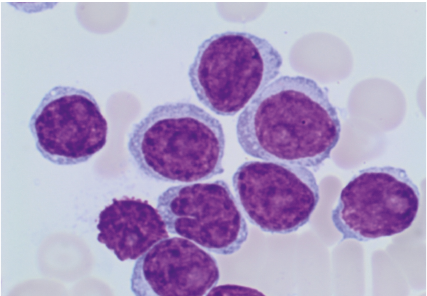
Figure 1: Peripheral blood smear. The lymphoid cells are of intermediate to large size with a prominent nucleolus and cytoplasm protrusions (Wright-Giemsa, ×